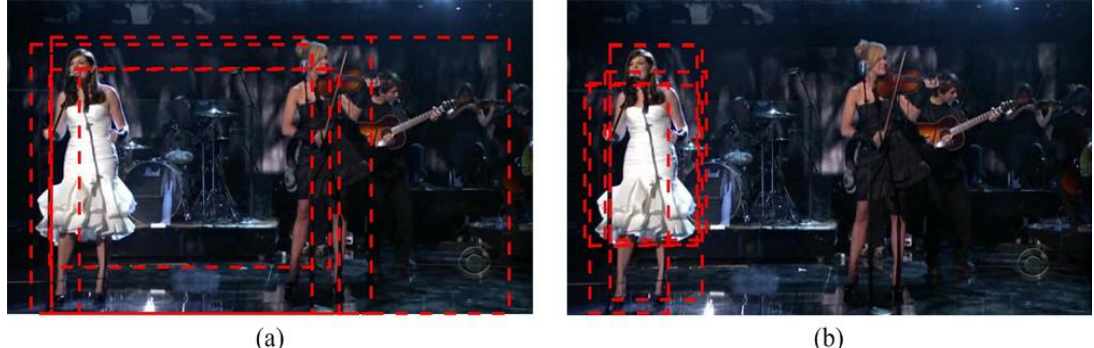
Figure 2. Examples of object proposals on image sequence Singer 1 . ( a ) Top five object proposals generated by EdgeBoxes. ( b ) Top five object proposals generated by modified EdgeBoxes. generated by EdgeBoxes. ( b ) Top five object proposals generated by modified